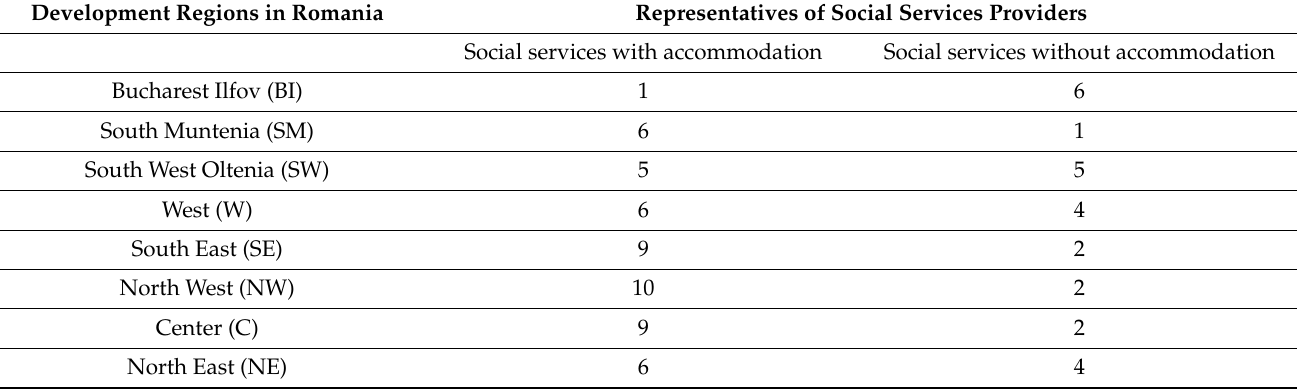
Table A1. Situation of social services providers who participated in the regional focus groups. Development Regions in